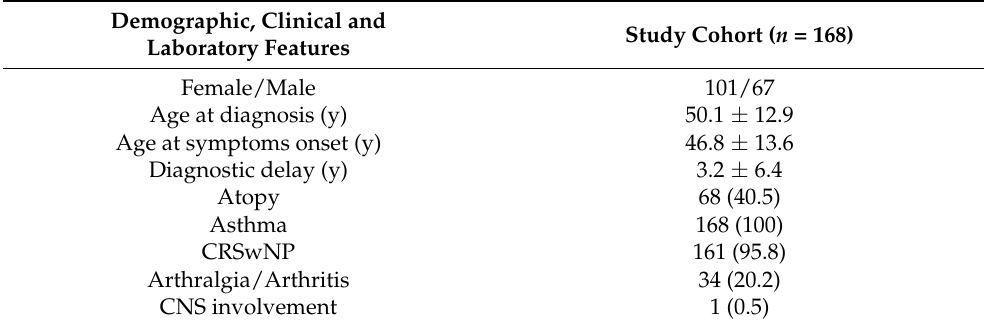
Table 1. Baseline characteristics of the study population. Data are presented as mean ± standard deviation or number